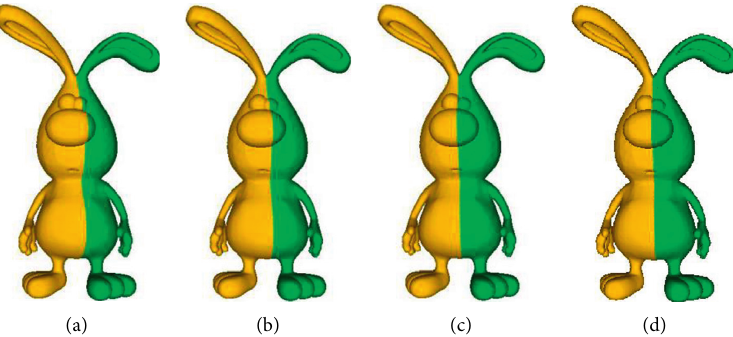
Figure 6: The iteration procedure of the proposed algorithm, taking rabbit model for example. (a) i � 0. (b) i � 1. (c) i � 2. (d) i � 3.